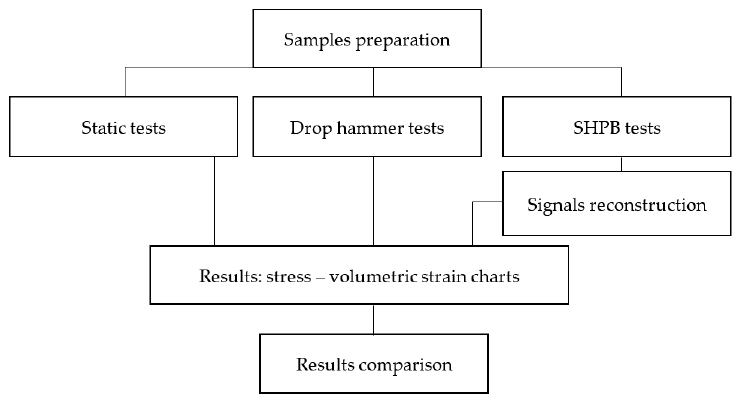
Figure 7. Schematic diagram of experimental research process.